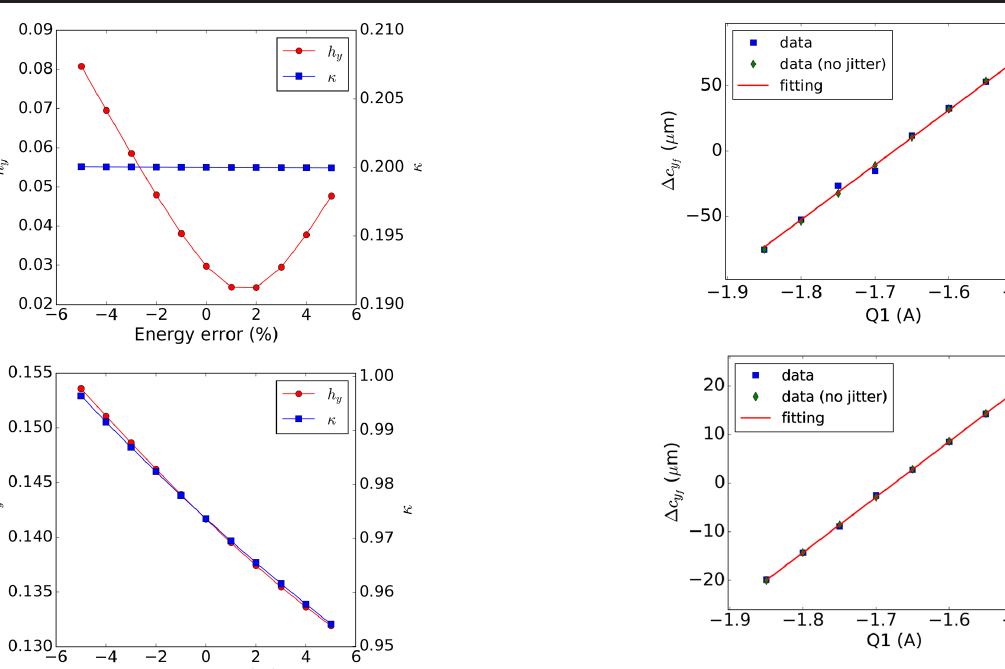
FIG. 8. Fits in the vertical plane for the first (top) and the third (bottom) bunches in the train. Only the RFD voltage jitter is included. The data points without any jitter are also plotted together for comparison.